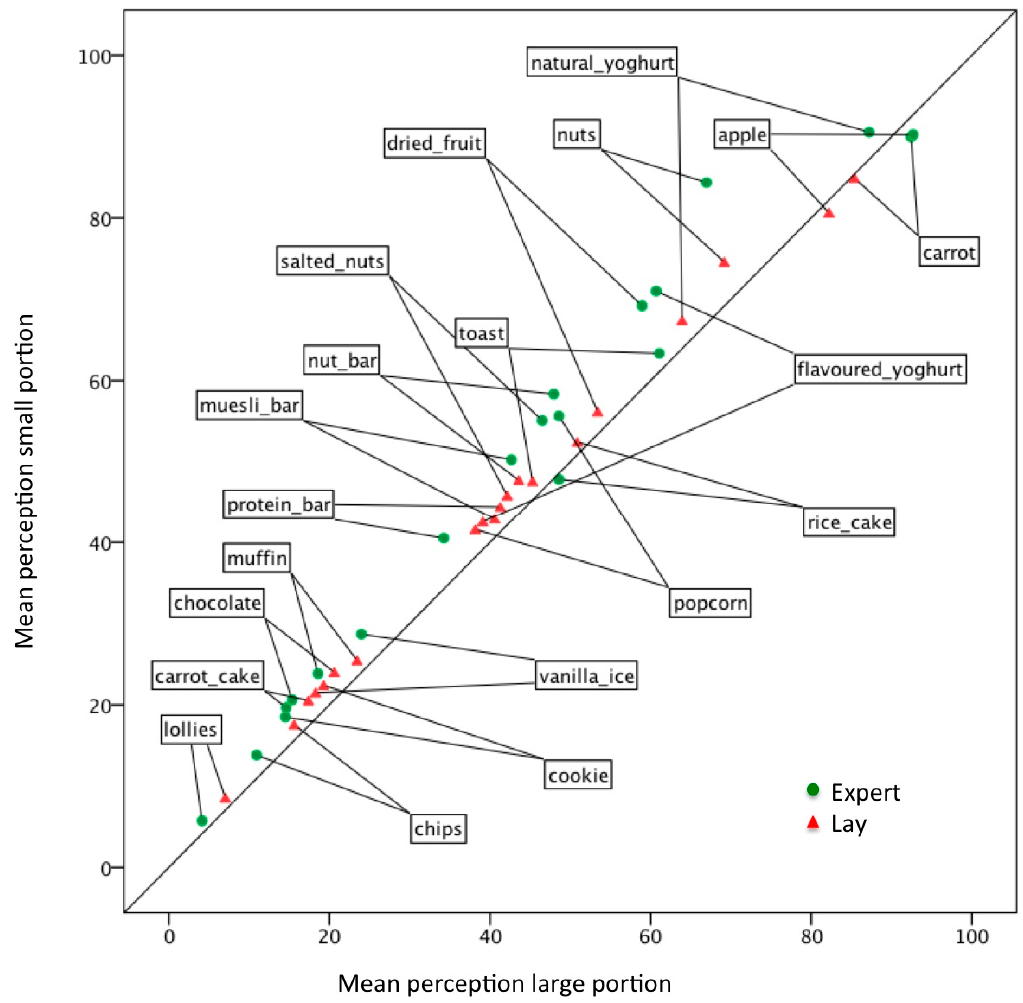
Figure 2. Perception of “nutritiousness” of different snacks ( N = 20) by nutrition experts ( N = 206) and lay participants ( N = 269). Large differences were found for lay and expert evaluations of yoghurt and toast, smaller differences were found for discretionary foods. Note that for most foods, a smaller portion was evaluated as more nutritious (above the reference line).